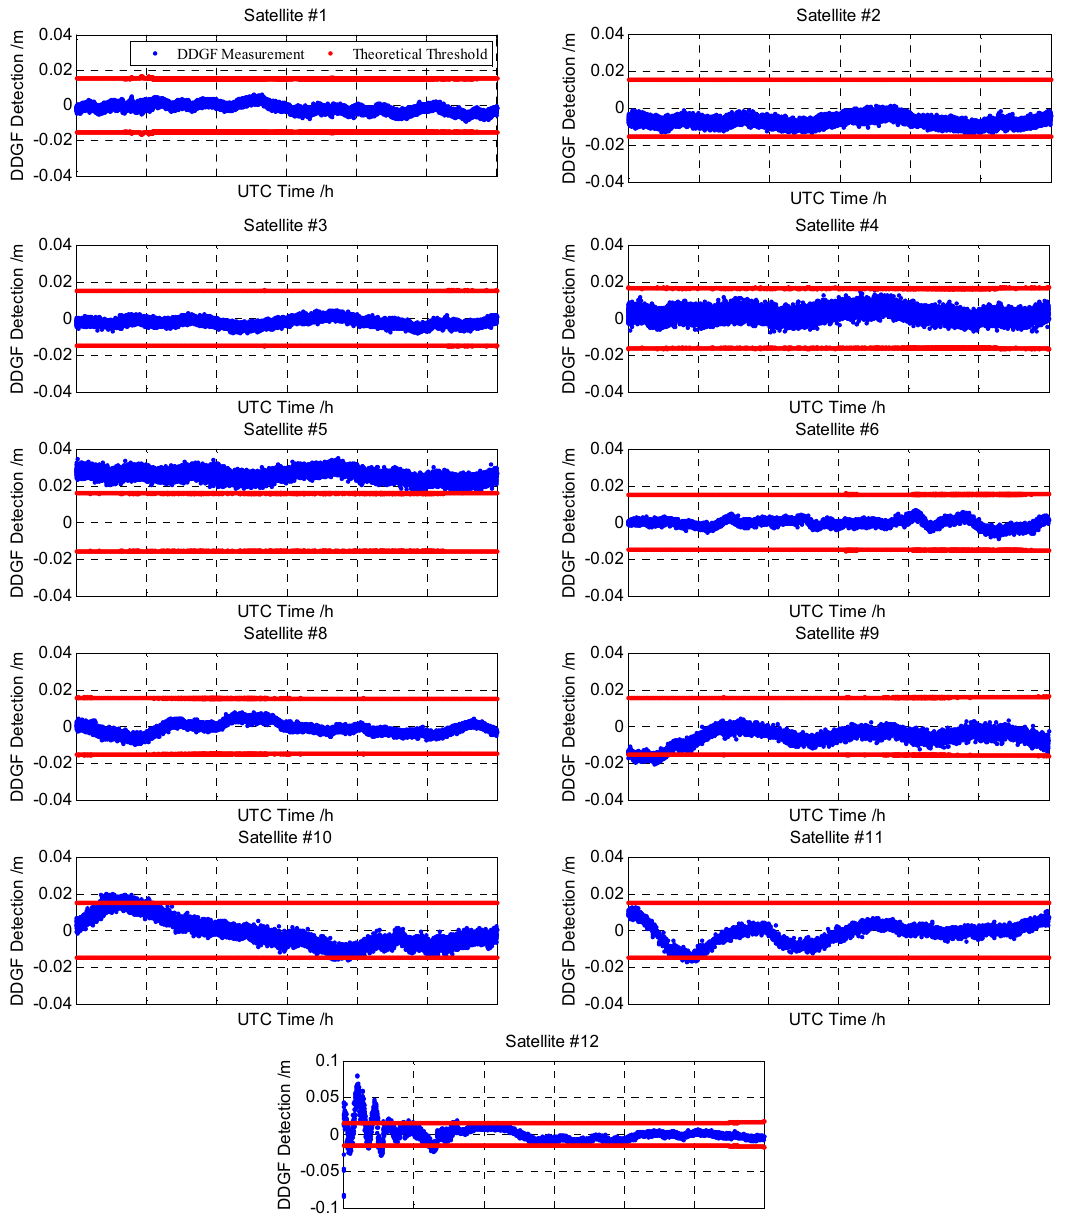
Figure 12. The DDGF detecting results of the manmade multipath test.